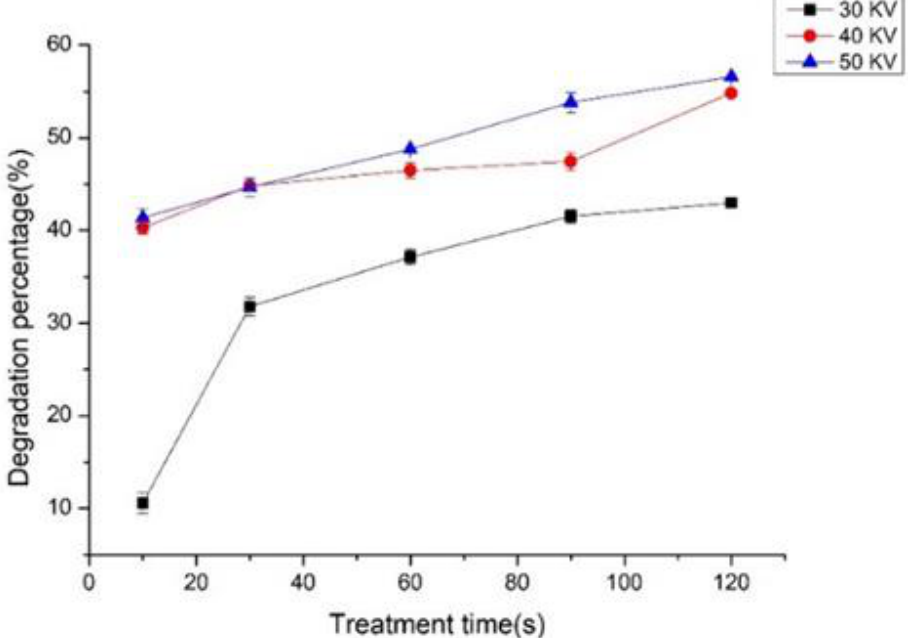
Figure 2. Voltage and time effects of DBD plasma on degradation percentage of zearalenone spiked in maize .